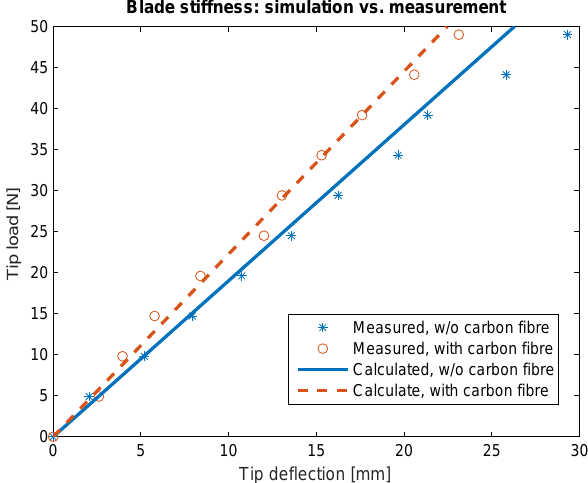
Figure 3. Structural behaviour of the bond between 3-D printed substrate and carbon fibre spar.